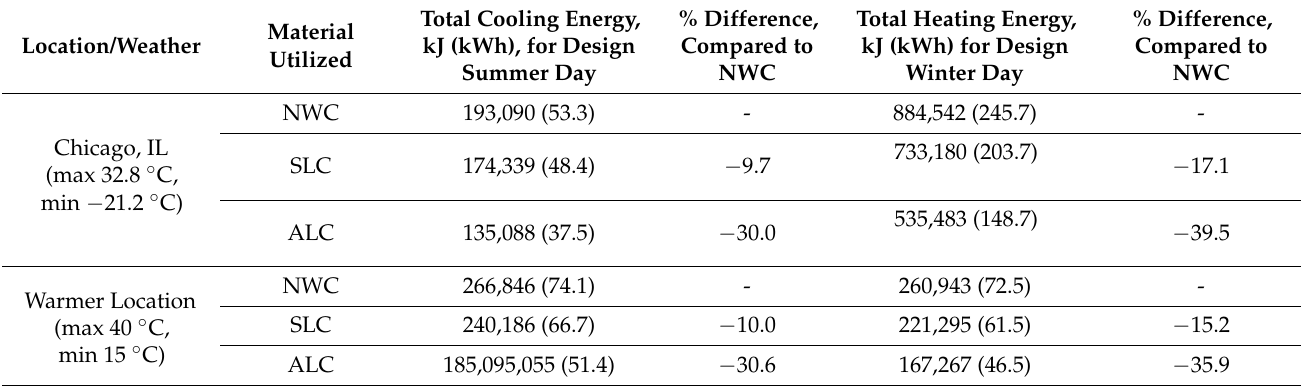
Table 8. Energy requirements for summer and winter design day for simple concrete structure in two weather scenarios, as predicted using EnergyPlus